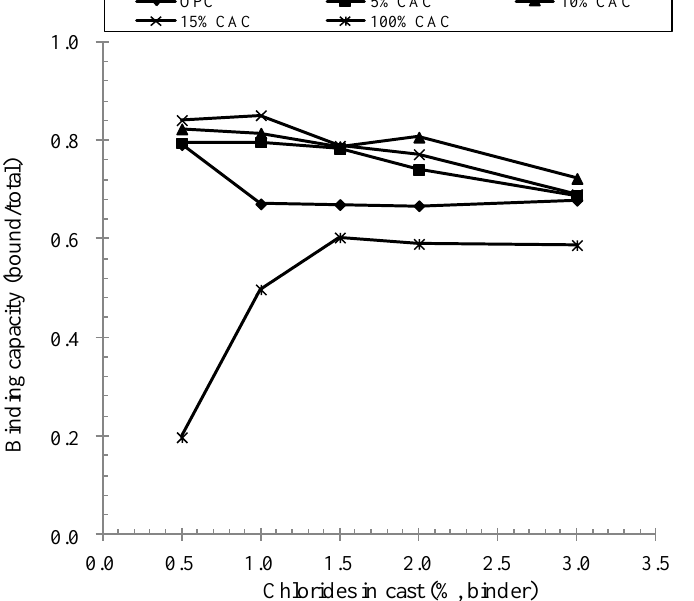
Figure 5. Binding capacity of chlorides in CAC and OPC